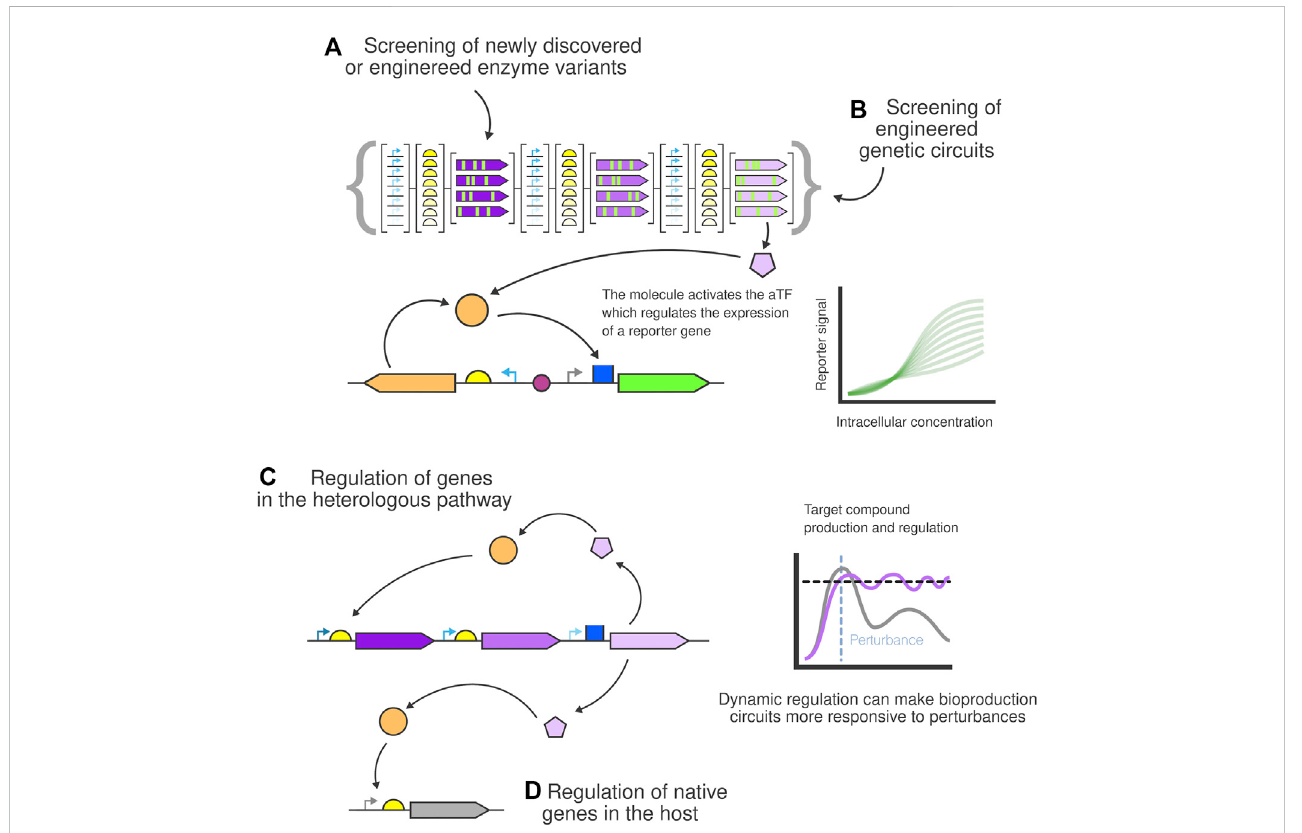
FIGURE 4 Bioproduction biosensor-based screening and dynamic regulation for bioproduction. New (A) enzyme variants and (B) genetic circuits can easily be screenedforproductionbylinkingtheproductionlevelsofthetargetmetabolitetotheoutputofthebiosensorreporter.Dynamicallyregulatedstrainscanbe built using biosensors to control the production of the compound by regulating (C) the metabolic pathway and (D) native genes of the